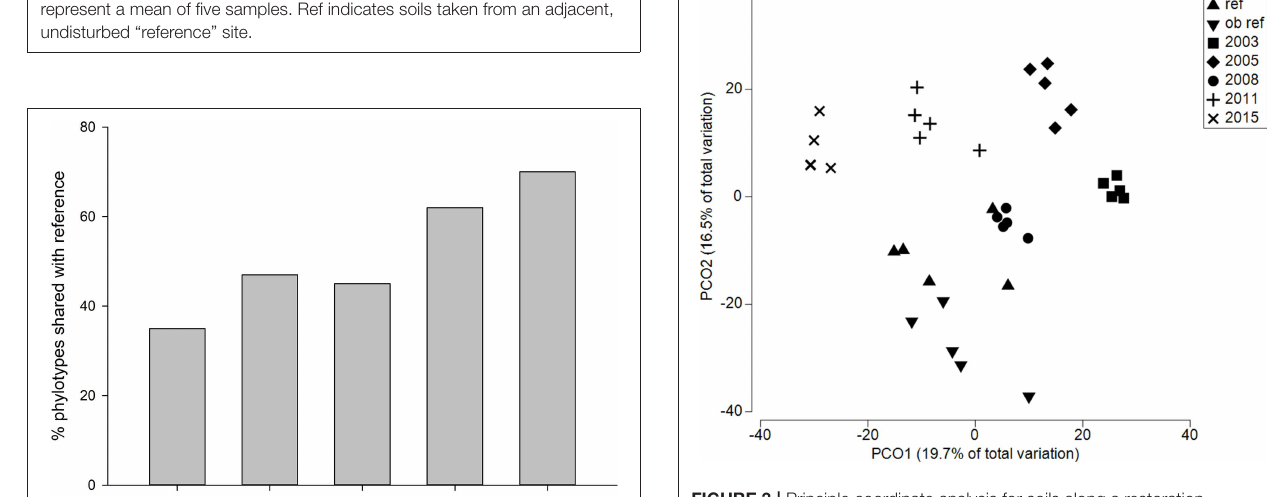
FIGURE 3 | Principle coordinate analysis for soils along a restoration chronosequence. Each symbol represents the fungal community within a single soil core. Ref refers to an adjacent, undisturbed site. All sites are significantly different from each other ( p < 0.0001).